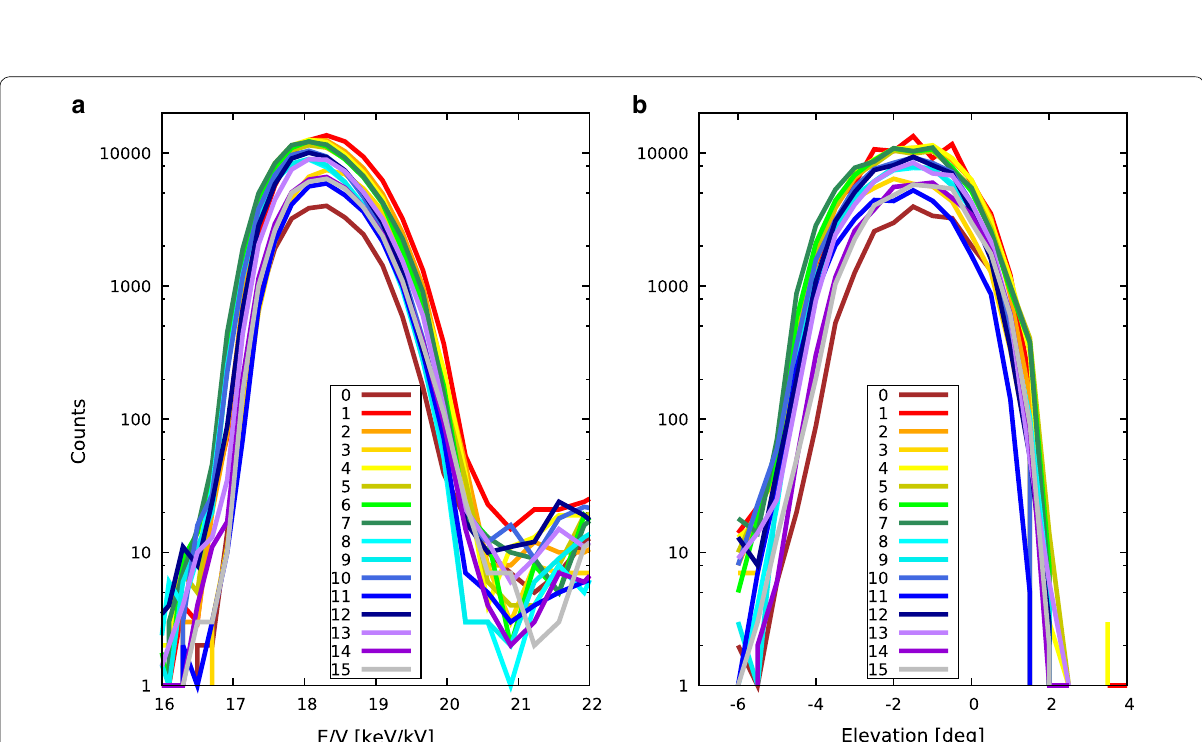
Fig. 6 a Energy and b angular responses of the 16 azimuthal channels for the 40-keV proton beam measured in the laboratory. The relative counts are not significant because they were dominantly due to the ion beam